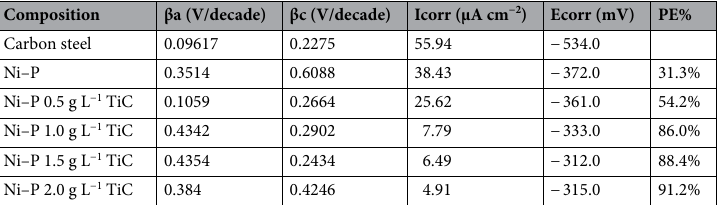
Table 4. Electrochemical parameters derived from the potentiodynamic polarization curve of carbon steel, Ni–P, and Ni–P-TiC composite coating containing various concentration of TiC particles.